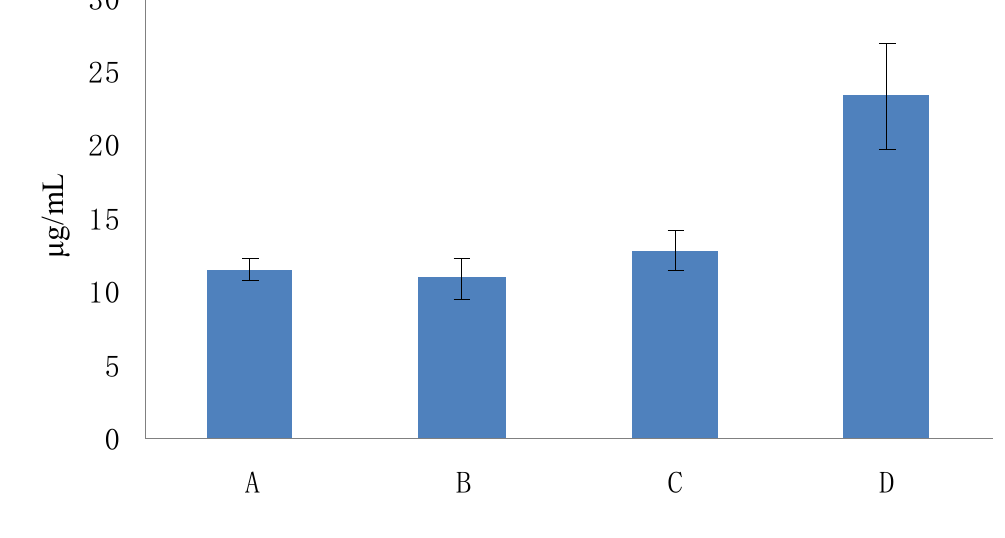
Figure 12. Hydroxyl radical-scavenging activity of Fuco stereoisomers and VE as a function of their EC . ( A ) (all- E )-Fuco; ( B ) 9' Z -Fuco; ( C ) 13 Z - and 13' Z -Fuco; ( D ) VE. 50s